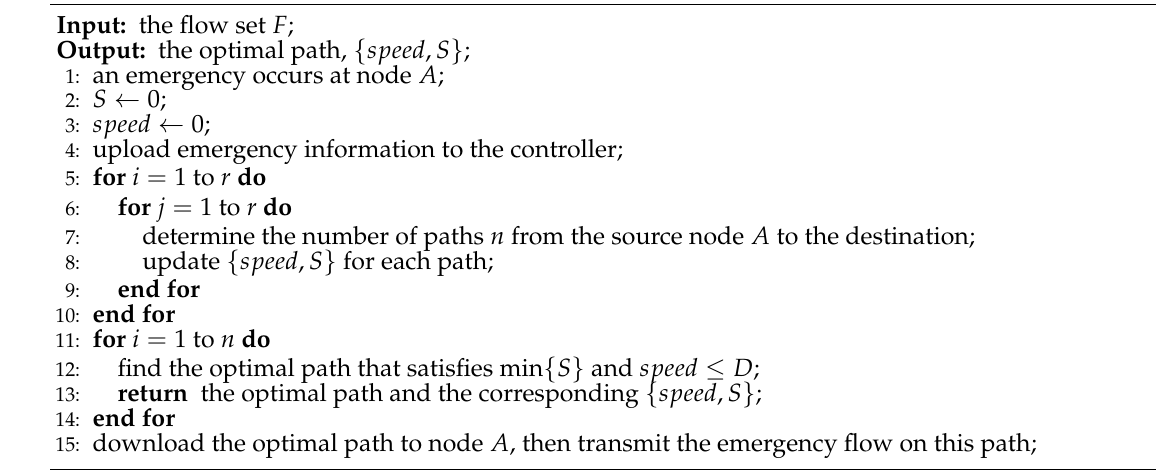
Algorithm 1 Optimal path scheduling